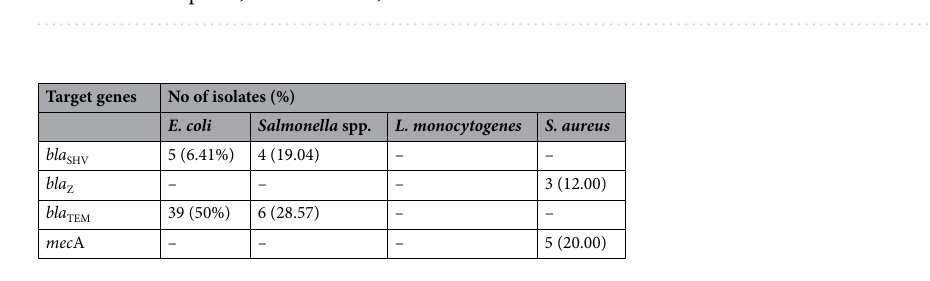
Table 3. Distribution of resistance genes in the selected foodborne bacterial isolated from bovine milk.